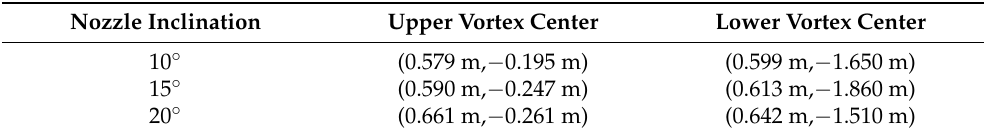
Figure 4. Flow contours of molten steel in mold. ( a ) SEN angle of 10 ◦ . ( b ) SEN angle of 15 ◦ . ( c ) SEN angle of 20 ◦ . Table 3. Upper and lower flow vortex core